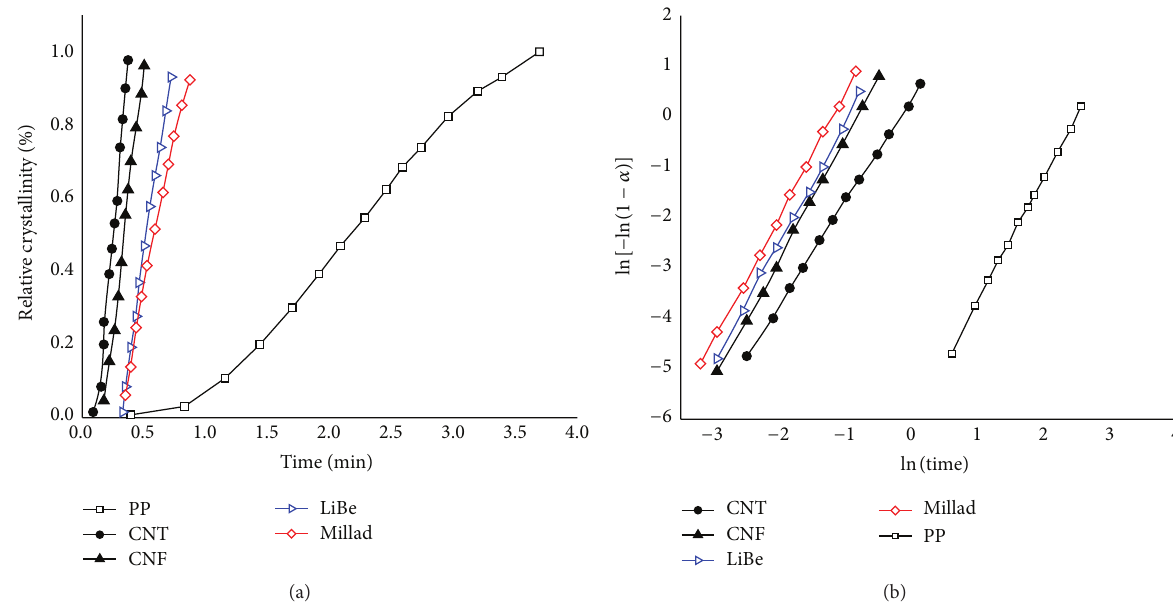
Figure 4: (a) Variation of the relative crystallinity versus time, of pure PP and PP with 0.1wt% nucleating agent. (b) Avrami plots of pure PP and PP with 0.1wt% nucleating agent at 120 ∘ C.